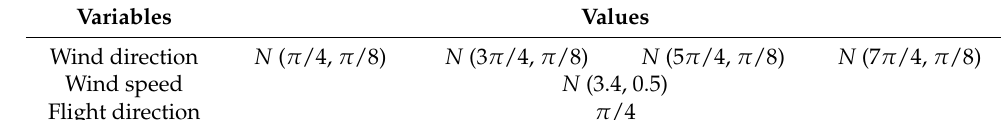
Table 9. Parameters for different wind directions.